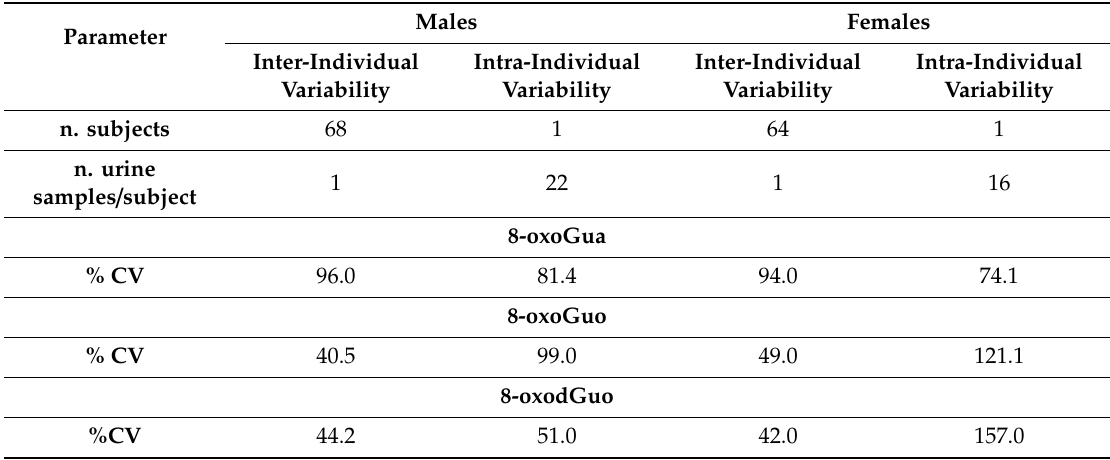
Table 2. Inter and intra individual variability for the concentrations of the oxidation biomarkers. Males Females Parameter Inter-Individual Intra-Individual Inter-Individual Intra-Individual Variability Variability Variability